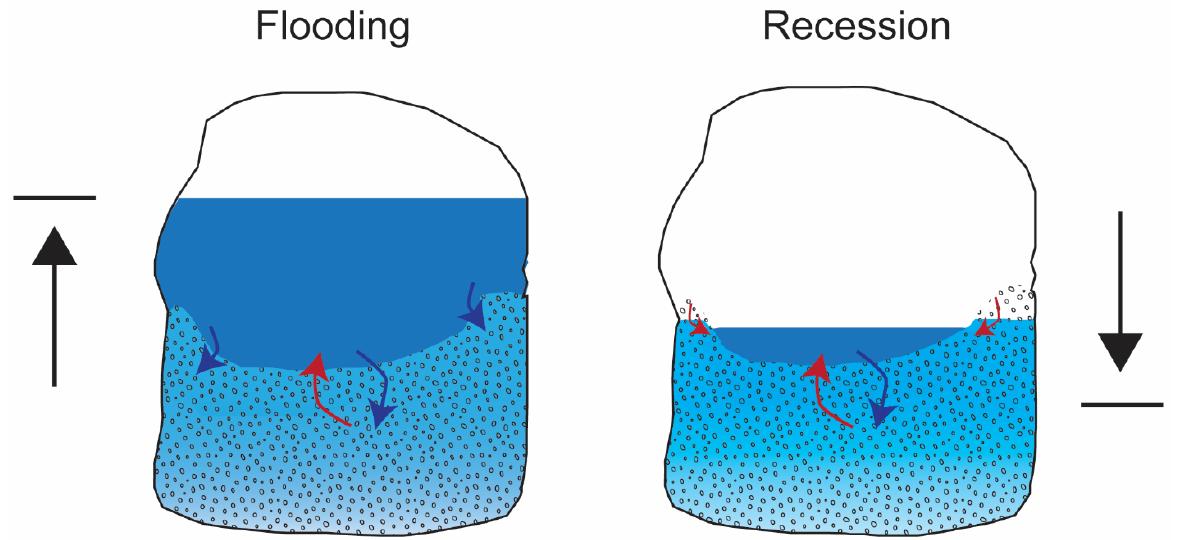
Figure 9. Cross section of a Maaras cave conduit showing a conceptual model of how heat transfer functions during flooding and recession inside the cave. Red arrows show positive heat exchange while blue arrows indicate negative heat exchange.